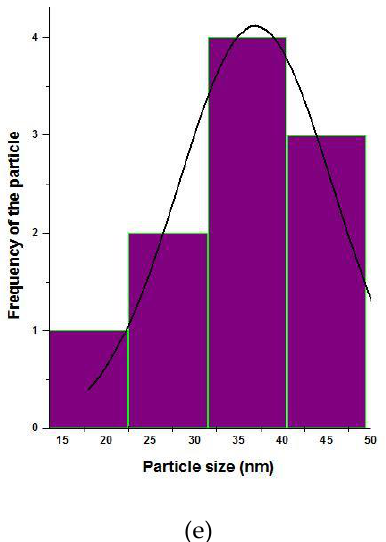
Figure 4. ( a – c ) TEM images of ZnO NPs and ( d ) SAED pattern of ZnO NPs - particle size histogram ( e ) Particle size histogram.